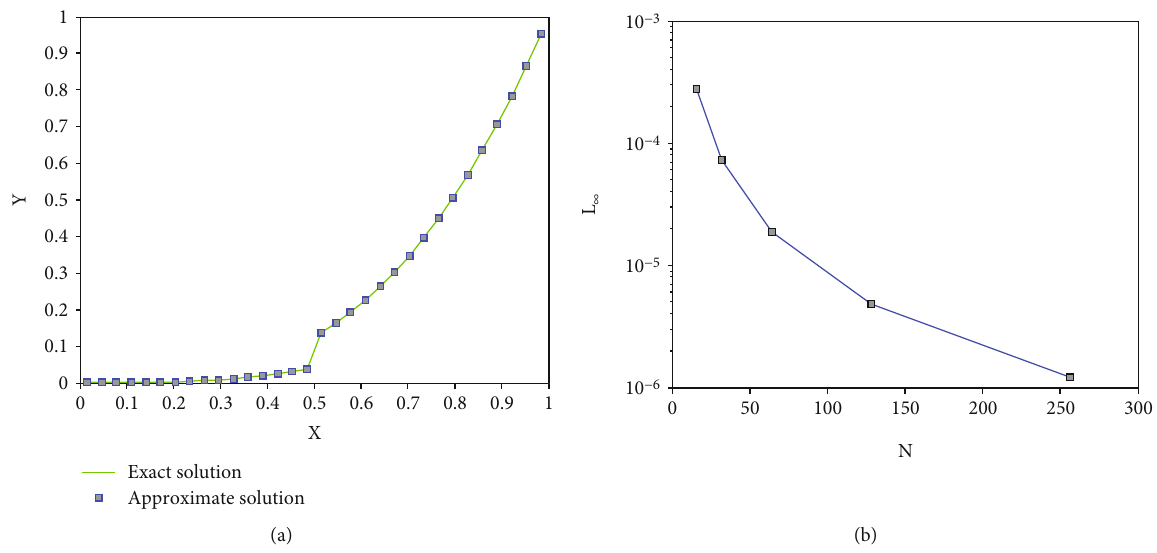
Figure 2: Comparability of exact and estimated solution for N = 32 (a) and plot of E